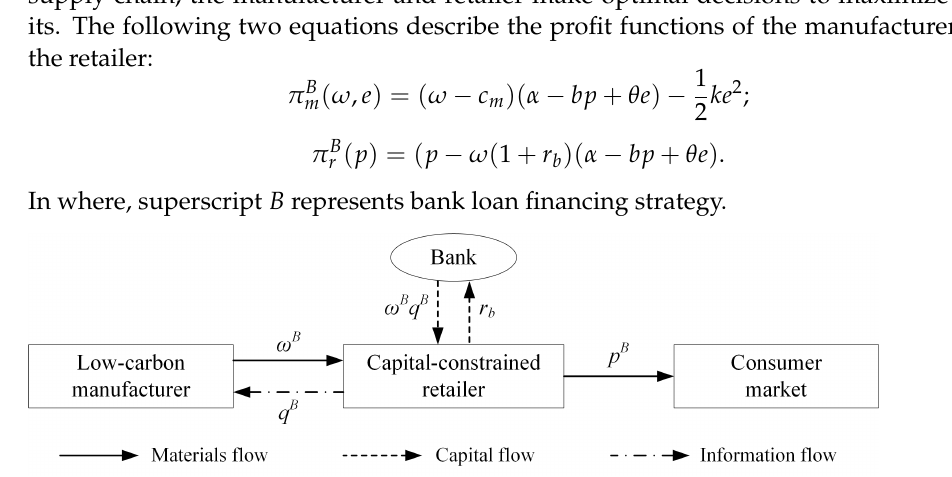
Figure 1. Bank loan financing